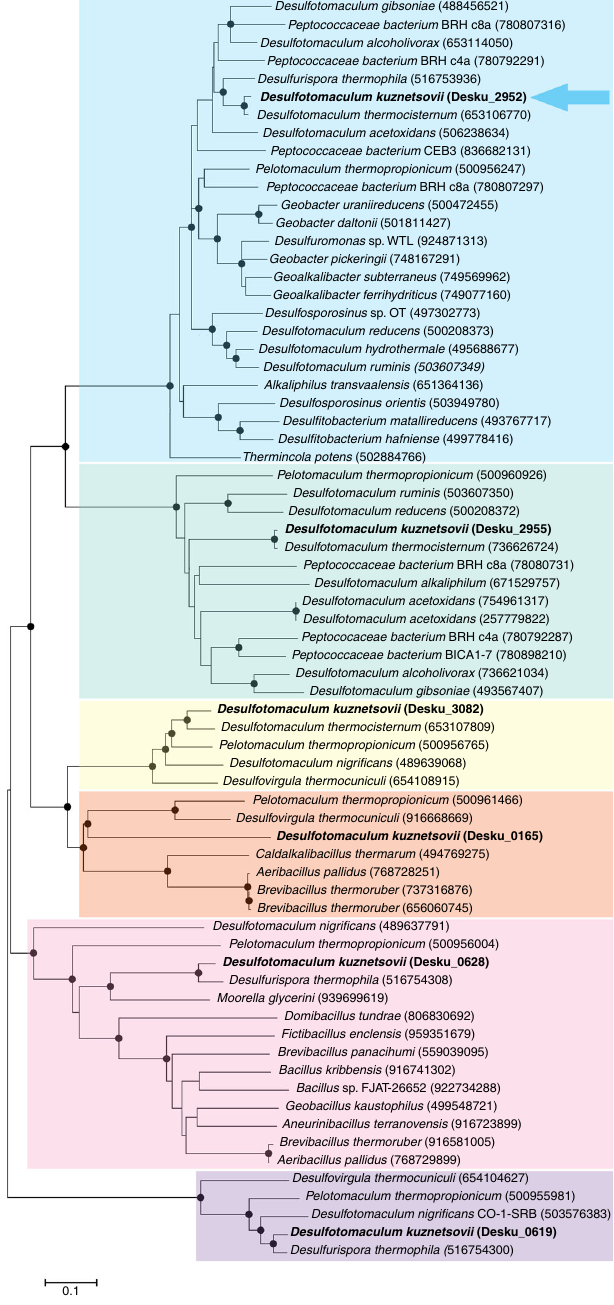
Fig. 4 Neighbor-joining tree based on ADH amino acid sequences. The sequences were obtained from a BLASTp analysis, using ADHs of D . kuznetsovii as query sequences. ADHs of D. kuznetsovii are printed in bold and an arrow points at the methanol-oxidizing ADH. Closed circles represent bootstrap values of 75% or higher. Scale bar represents 10% sequence difference